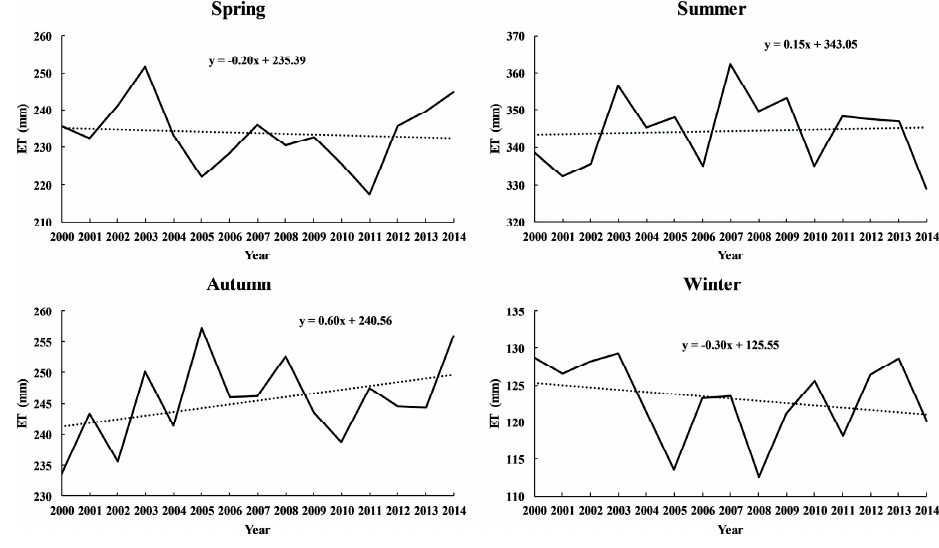
Figure 4. Variation in seasonal ET in the PRB. Table 2. Monthly variation in ET in the PRB (mm).